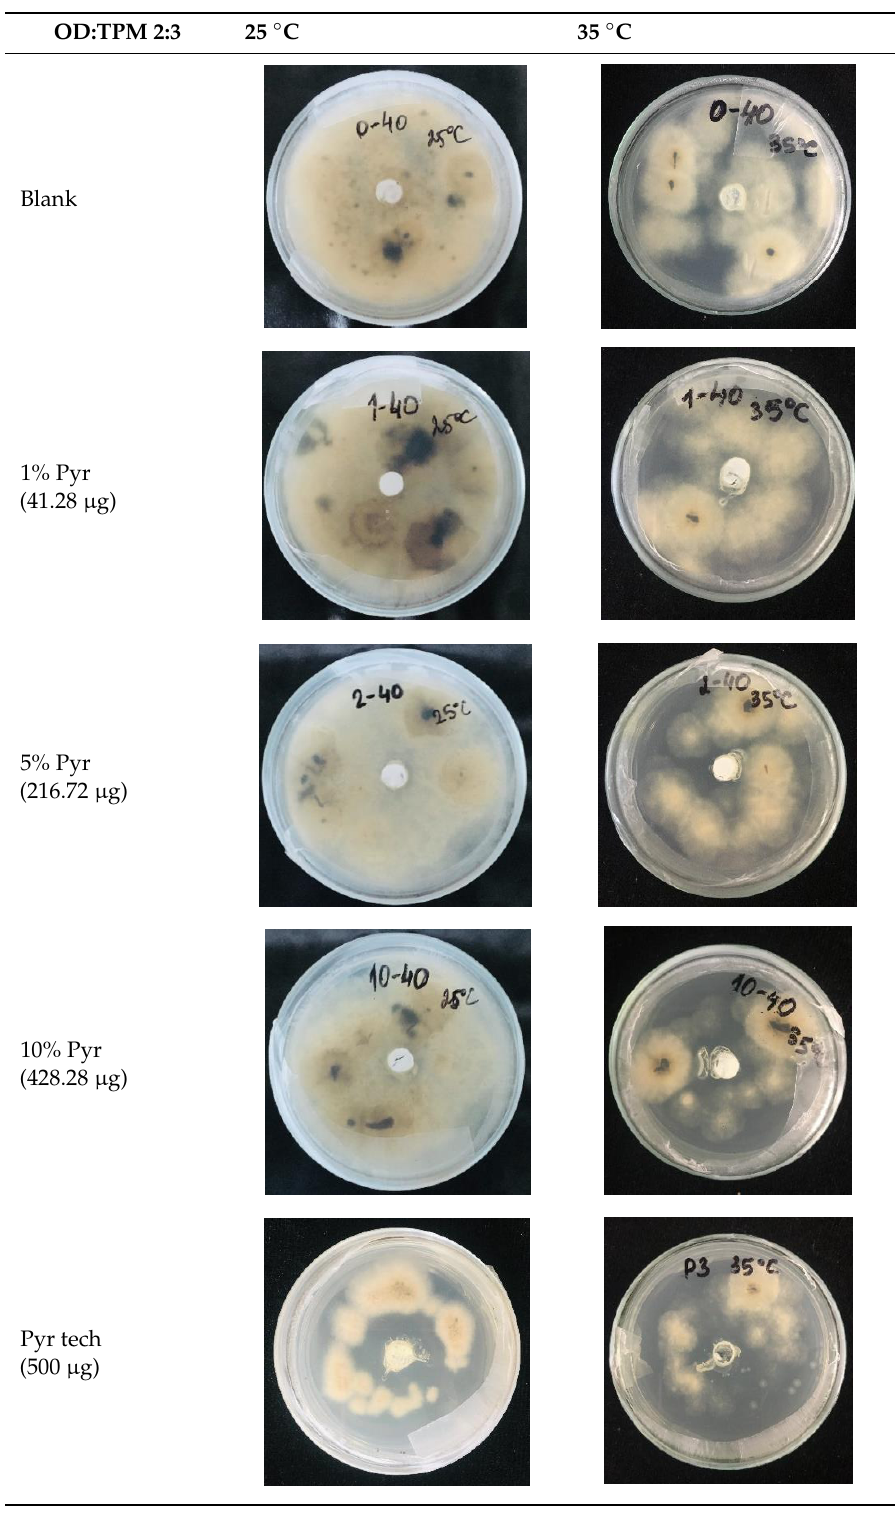
Table 4. Antifungal activity for blank and Pyr-loaded SMCs at OD:TPM ratio of 2:3 at 25 and 35 °C.